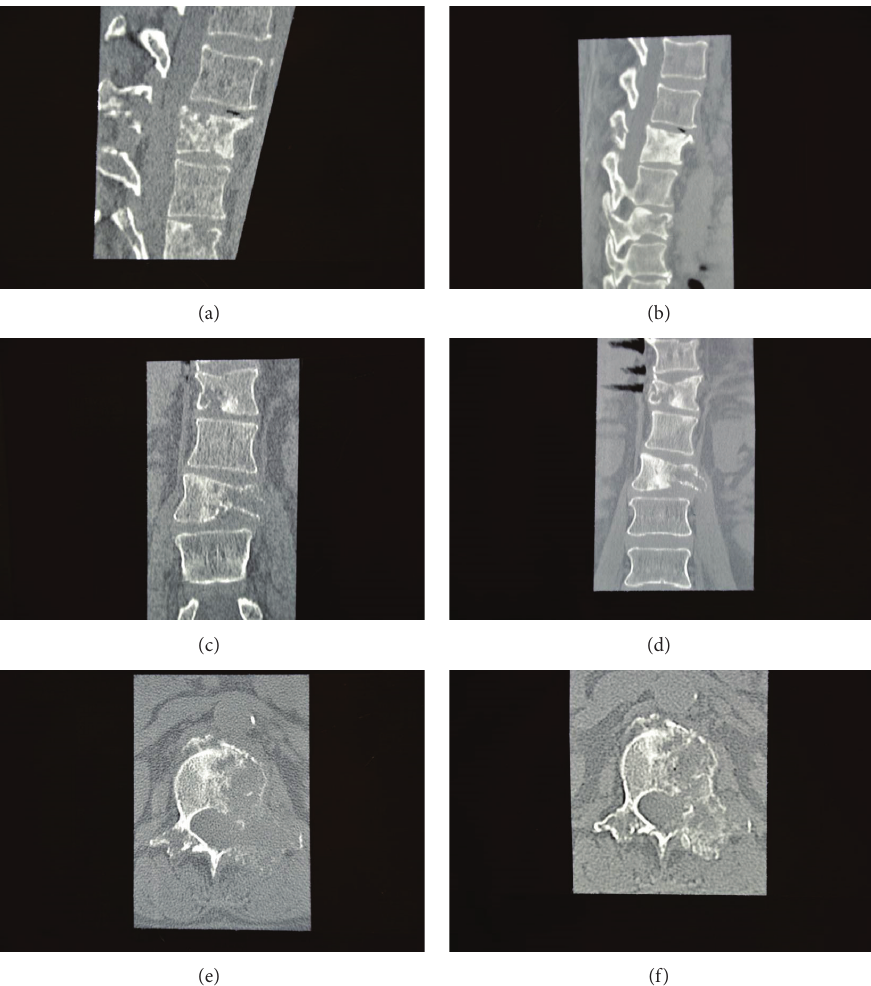
Figure 1: Case 1—computed tomography of thoracolumbar spine, noncontrast, demonstrating the development of bone remodeling and sclerosis 11 weeks after the initiation and 2 weeks after the completion of IAC (the vertebral body with maximal compression is L1). Sagittal before (a) and after (b), coronal before (c) and after (d), and axial L1 level before (e) and after (f)